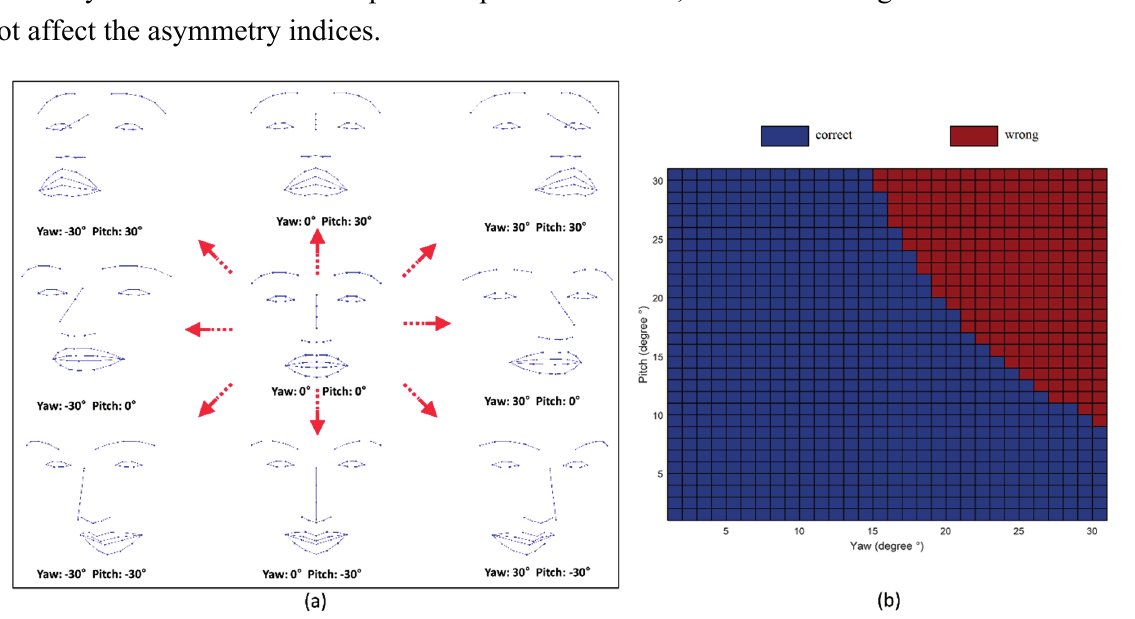
Figure 8. Simulation results of estimating facial nerve palsy among various head pose. ( a ) Examples of projected 2D synthetic face with various head-orientations; ( b ) Simulation results of facial nerve palsy estimation by using best features (forehead_region, mouth_axis) and LDA. The blue color represents the correct estimation, and the red color represents wrong estimation. The results of roll movements are not showed in this figure because there was no change in the asymmetry index within the roll angle from − 30° to